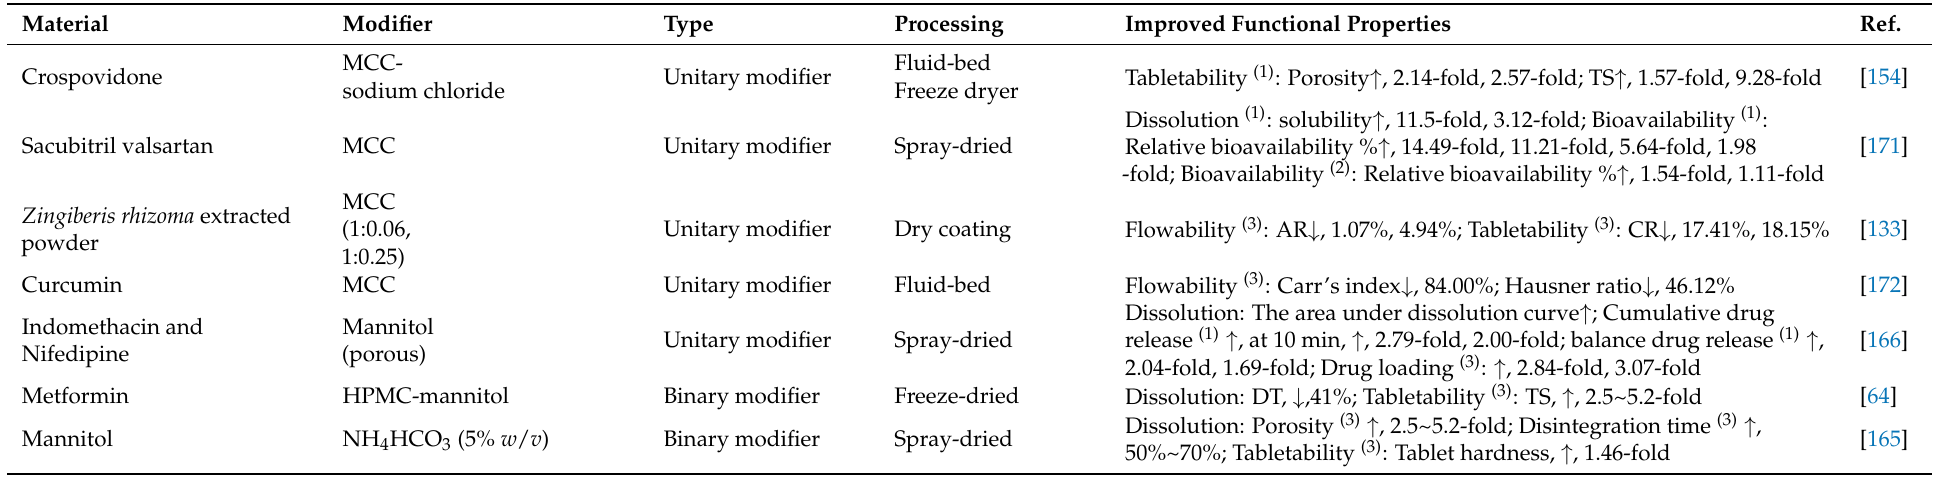
Table 4. The application of MCC and